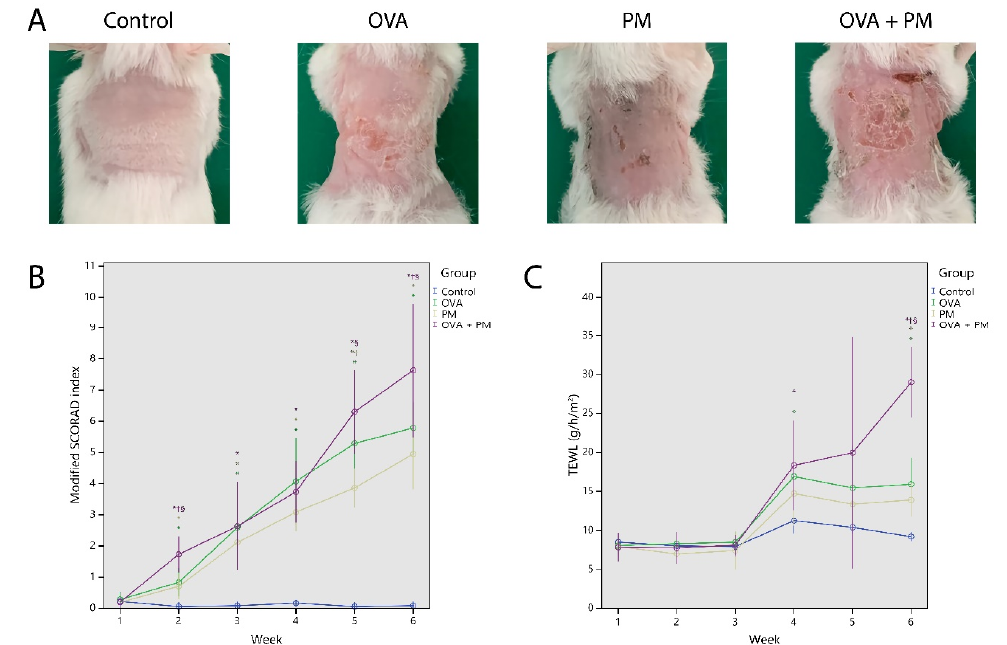
Figure 1. ( A ) Macroscopic findings of the dorsal skin of mice. ( B ) The modified scoring atopic dermatitis (SCORAD) index. ( C ) The trans-epidermal water loss (TEWL). * p < 0.05 compared to control, † p < 0.05 compared to OVA, § p < 0.05 compared to PM 10. Int. J. Mol. Sci. 2018 , 19 , x FOR PEER REVIEW OVA (OVA group) and PM 10 (PM group) application caused an increase in trans-epidermal water loss (TEWL). TEWL at Week 6 was significantly higher in the OVA group (15.9 ± 3.66) and the PM group (13.9 ± 1.99), compared to control (9.20 ± 0.56) ( p < 0.01). TEWL of the OVA + PM group